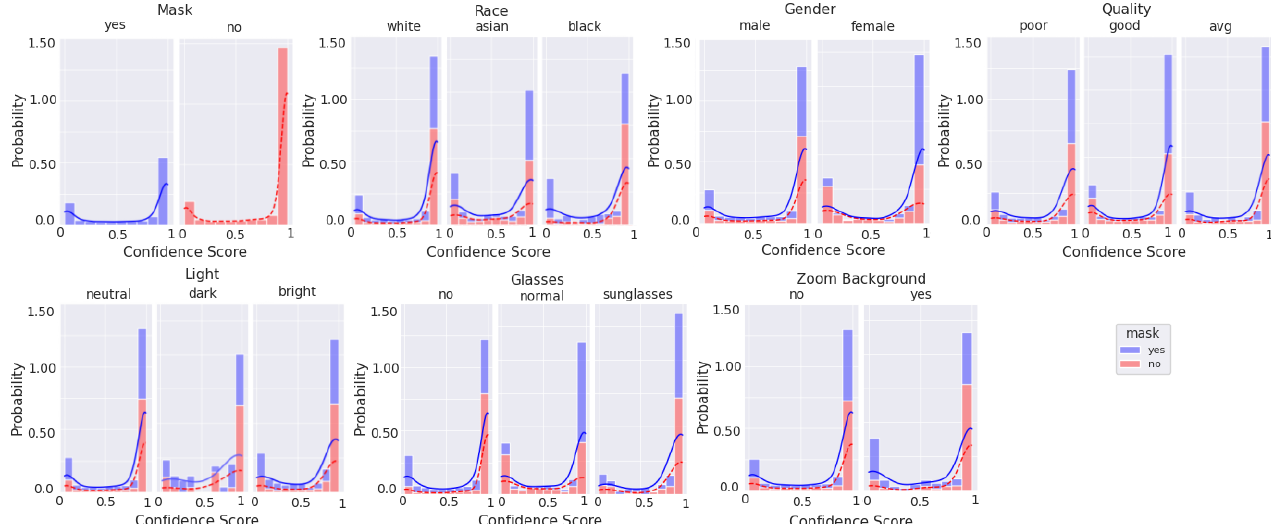
Figure 10. Histogram of categorical labels vs. confidence scores for all image qualities, as qualitatively evaluated, using the augmented MobileNetv2 model. For each category and its labels, ‘mask’ and ‘no mask’ data bins are stacked. The solid and dashed lines represent the KDE for ‘mask’ and ‘no mask’ image scores, respectively.